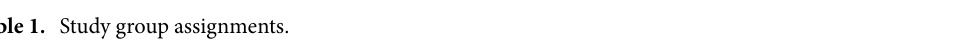
Table 1. Study group